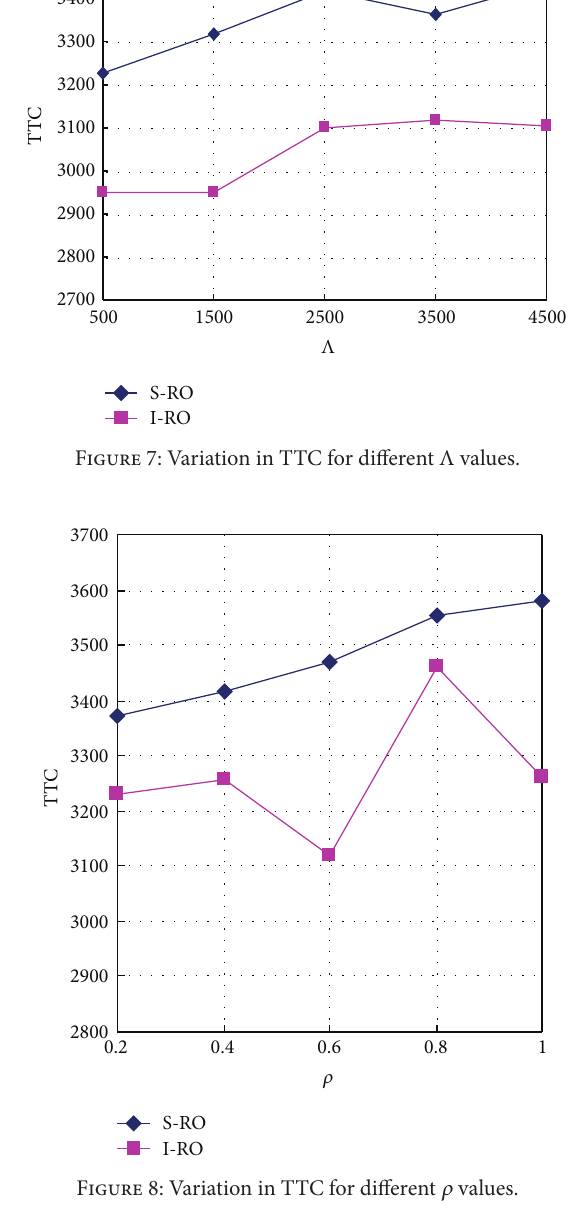
optimisation indices at the same time during the